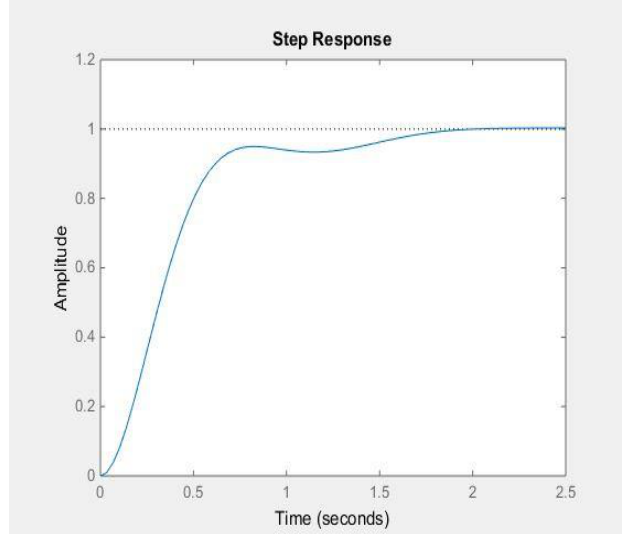
Fig. 12. Step Response of Mag Lev.